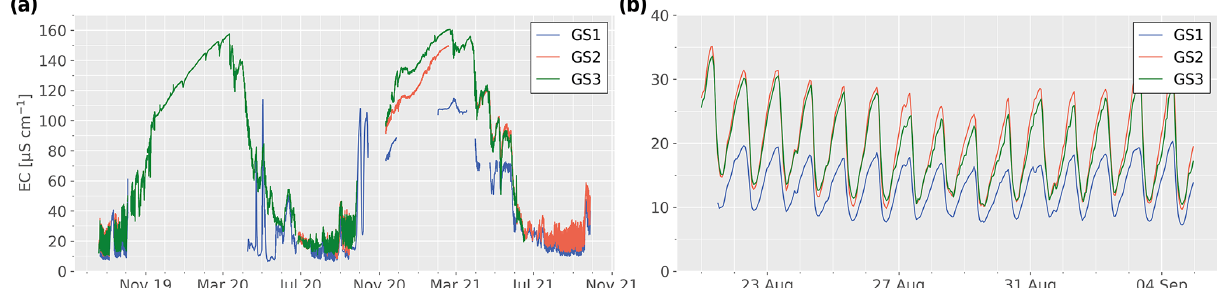
Figure 4. (a) Streamflow electrical conductivity (EC) at the three gauging stations (GS1 to GS3) during 2 years. (b) Zoom-in window showing the EC for the first 20d of measurement. Large gaps in winters are due to sensor